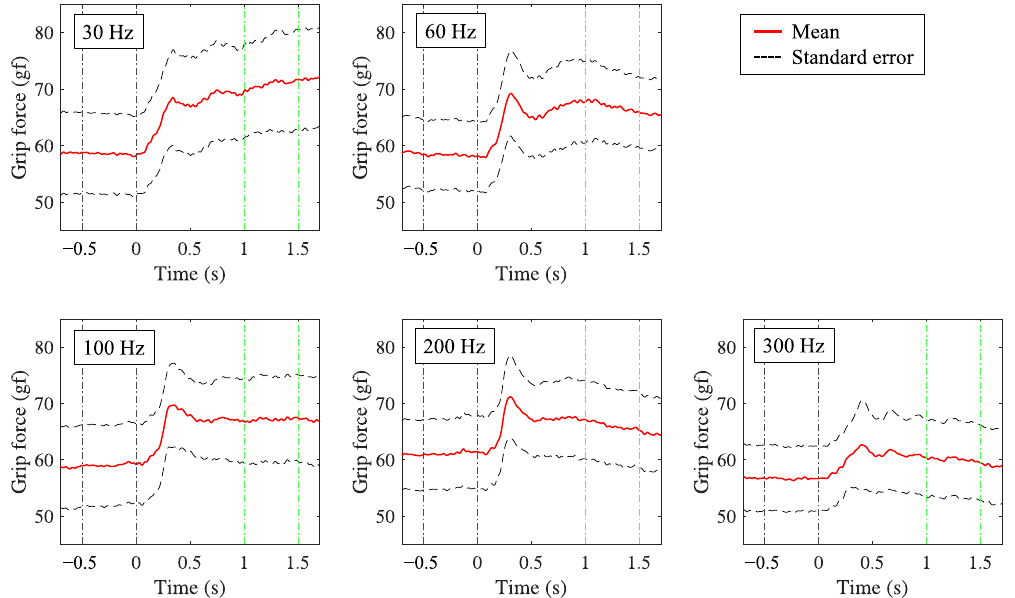
Figure 2. Grip force over time during Experiment 1. The red lines and dashed black lines indicate the means and range of standard errors, respectively. Stimuli started at 0 s and lasted 3 s. For the analysis of the change in grip force, means of 0.5 s before the stimulus ( − 0.5–0 s) and after the stimulus (1–1.5 s), which are surrounded by the black and green dashed lines, respectively, were